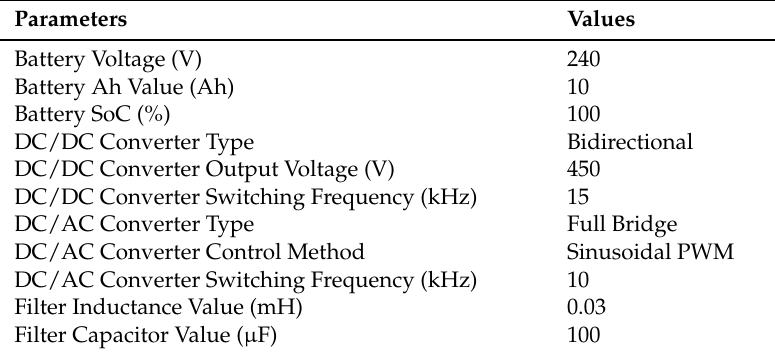
Table 1. Parameters of the simulation system.